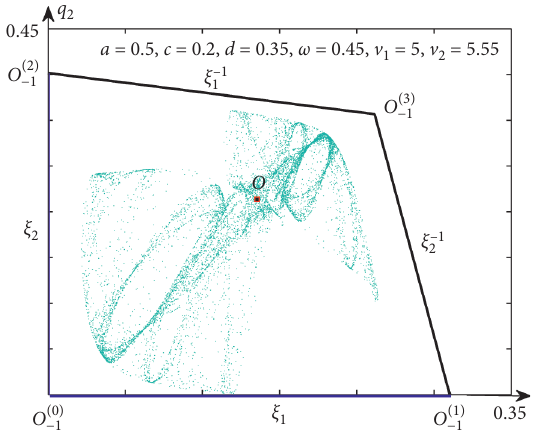
Figure 4: The boundaries of the chaotic attractor given in Figure